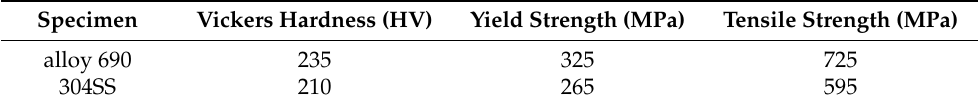
Table 2. Mechanical property of the